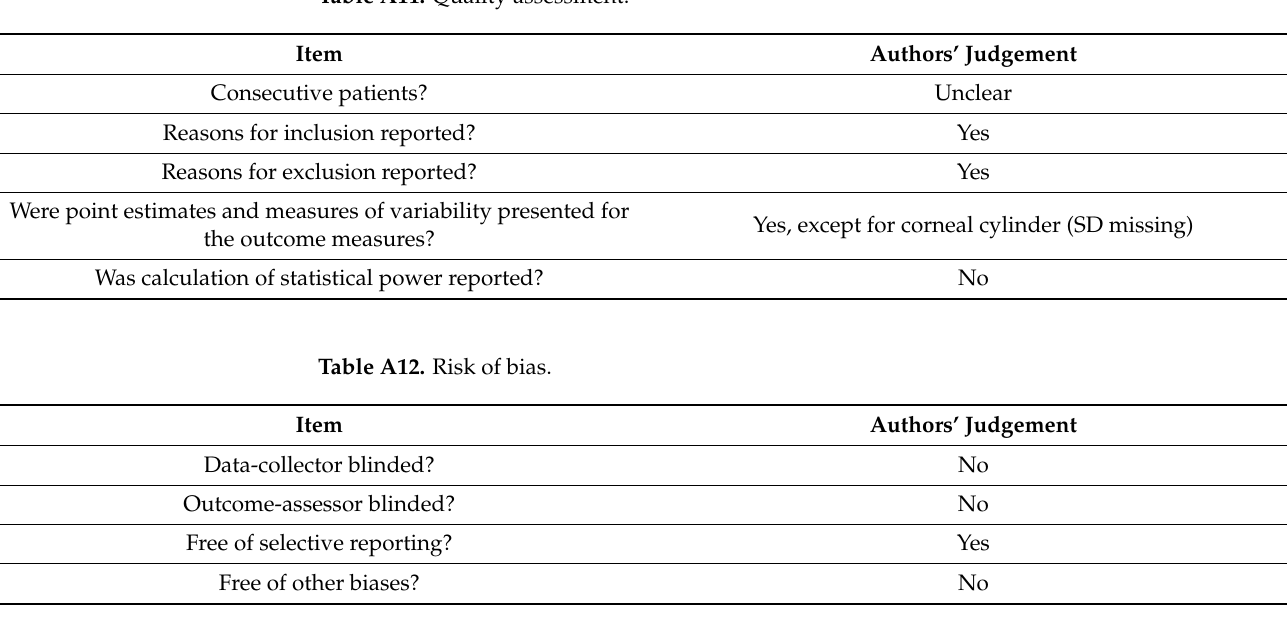
Table A11. Quality assessment.